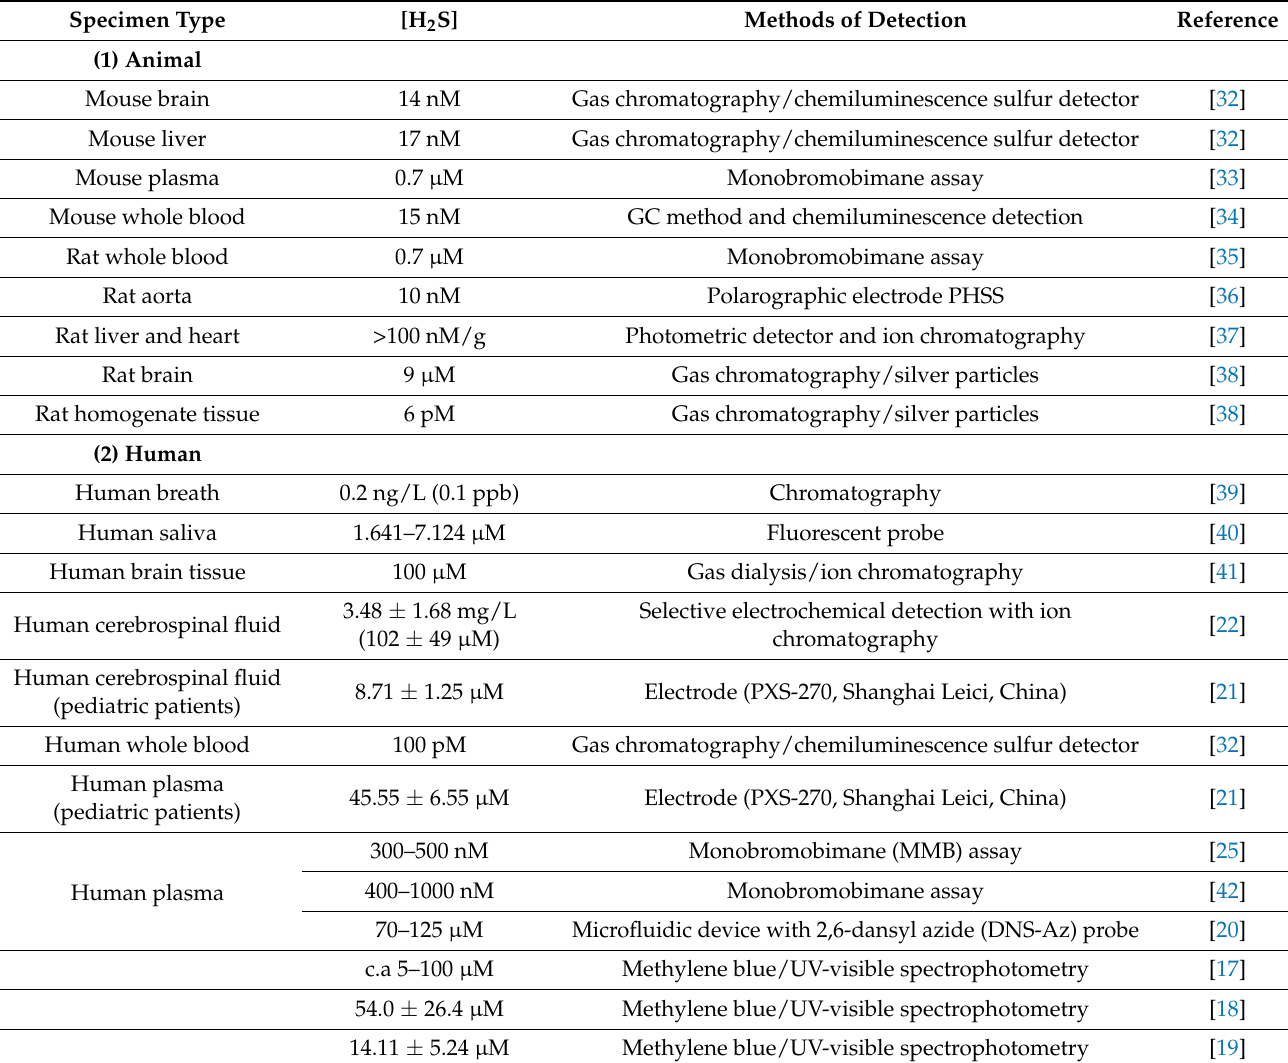
Table 1. Concentration of H 2 S in biological